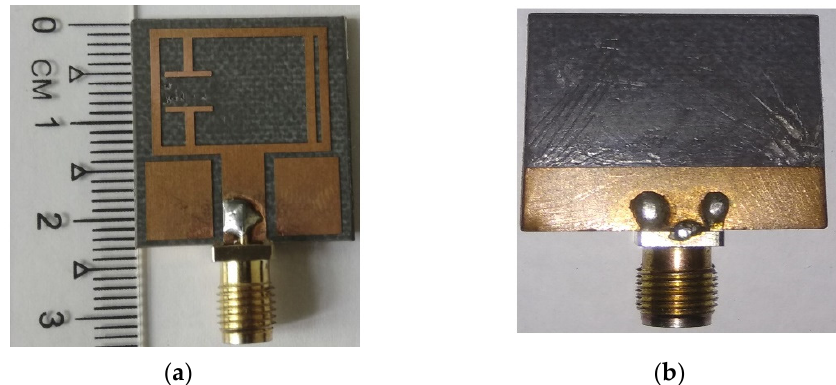
Figure 12. Fabricated ( a ) top view and ( b ) bottom view of the proposed antenna.